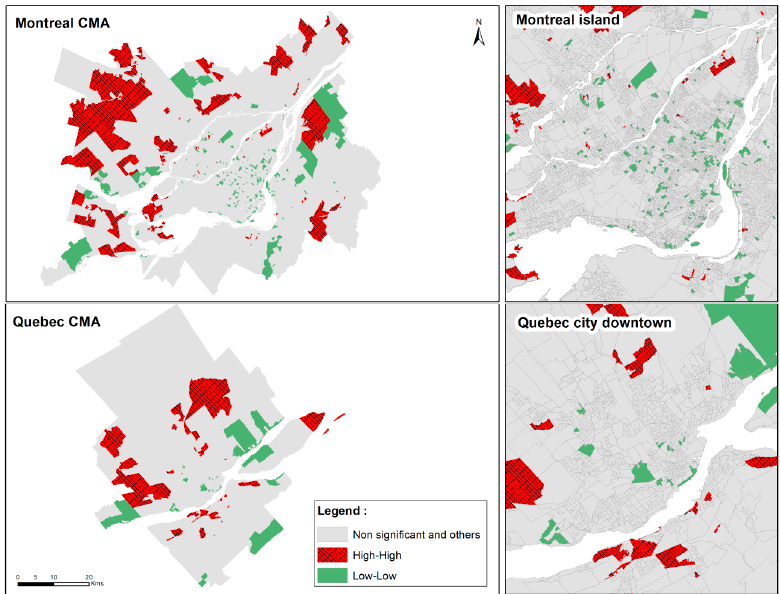
Figure 3. Bivariate local Moran maps of cerebrovascular standardized morbidity rates and distance to green spaces with sport facilities for adults ≥ 20 years living in the CMAs of Montreal and Quebec City, 2006 − 2011. CMA: Central Metropolitan Area; SMR: standardized morbidity rates; GSes: green spaces; High-High: Cluster of highest SMR and highest distance to GSes with sport facilities; Low-Low: Cluster of lowest SMR and lowest distance to GSes with sport facilities.